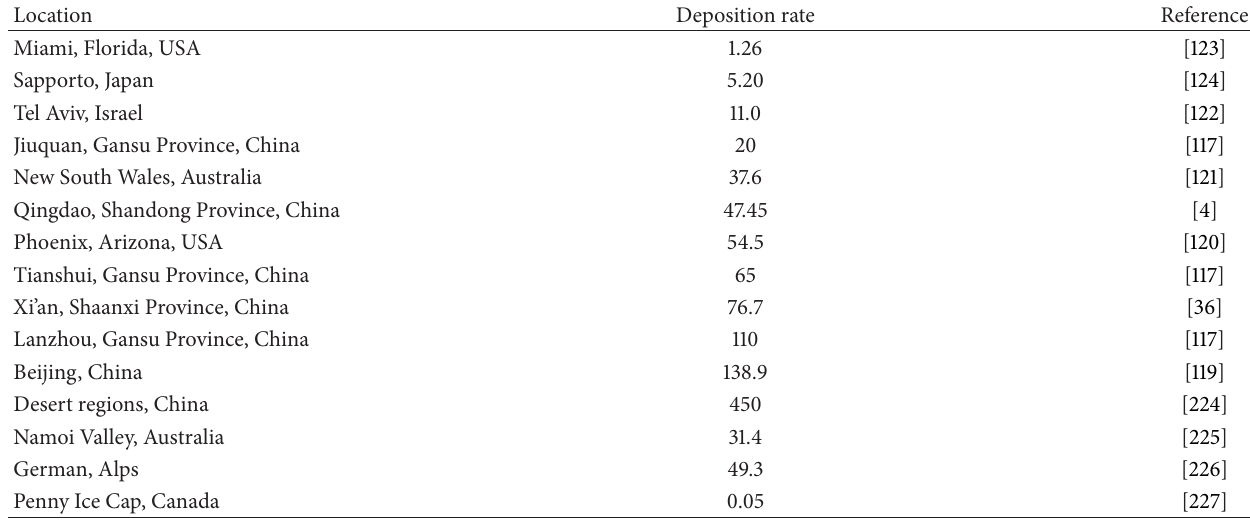
Table 7: Annual average dust deposition rates (gm −2 yr −1 ) in different sites throughout the